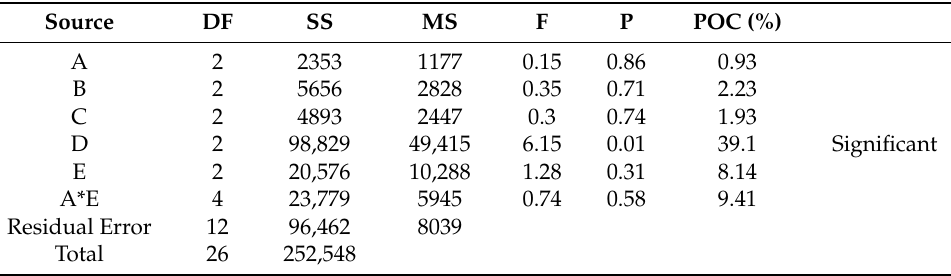
Table 9. ANOVA analysis of tool wear.